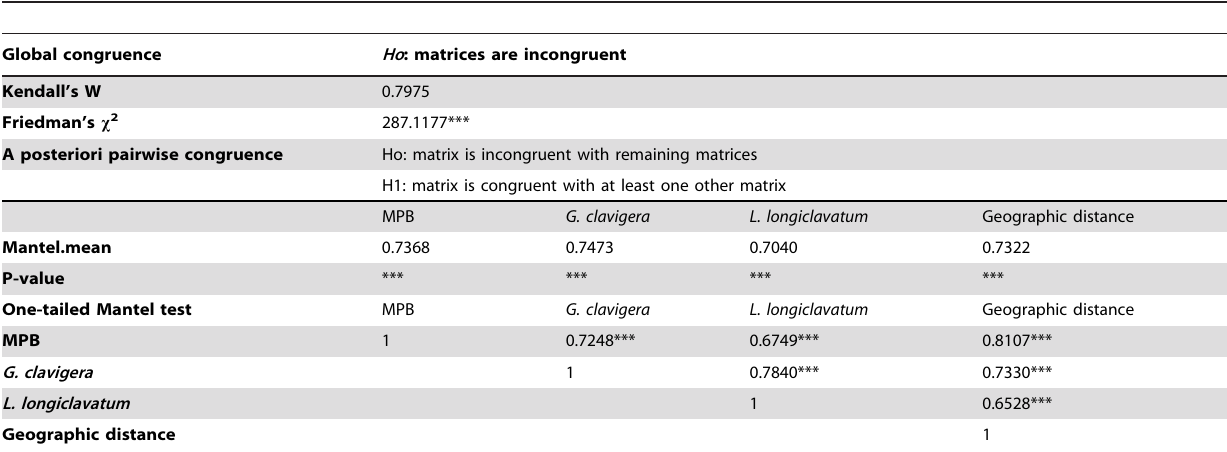
Table 7. Congruence among genetic distance matrices of two fungi, the mountain pine beetles and geographic distance among sampling locations using CADM implemented in the R